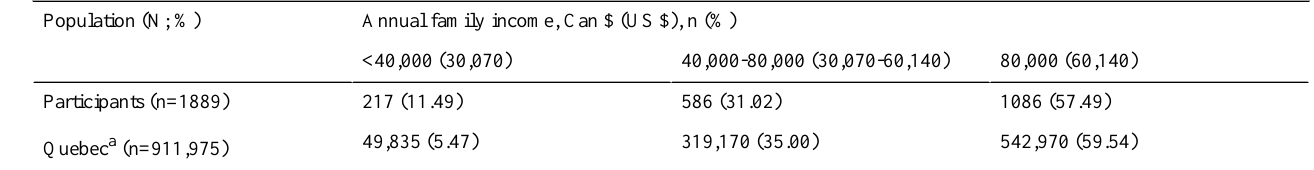
Table 2. Level of income: participants of the quantitative component versus couples with children in